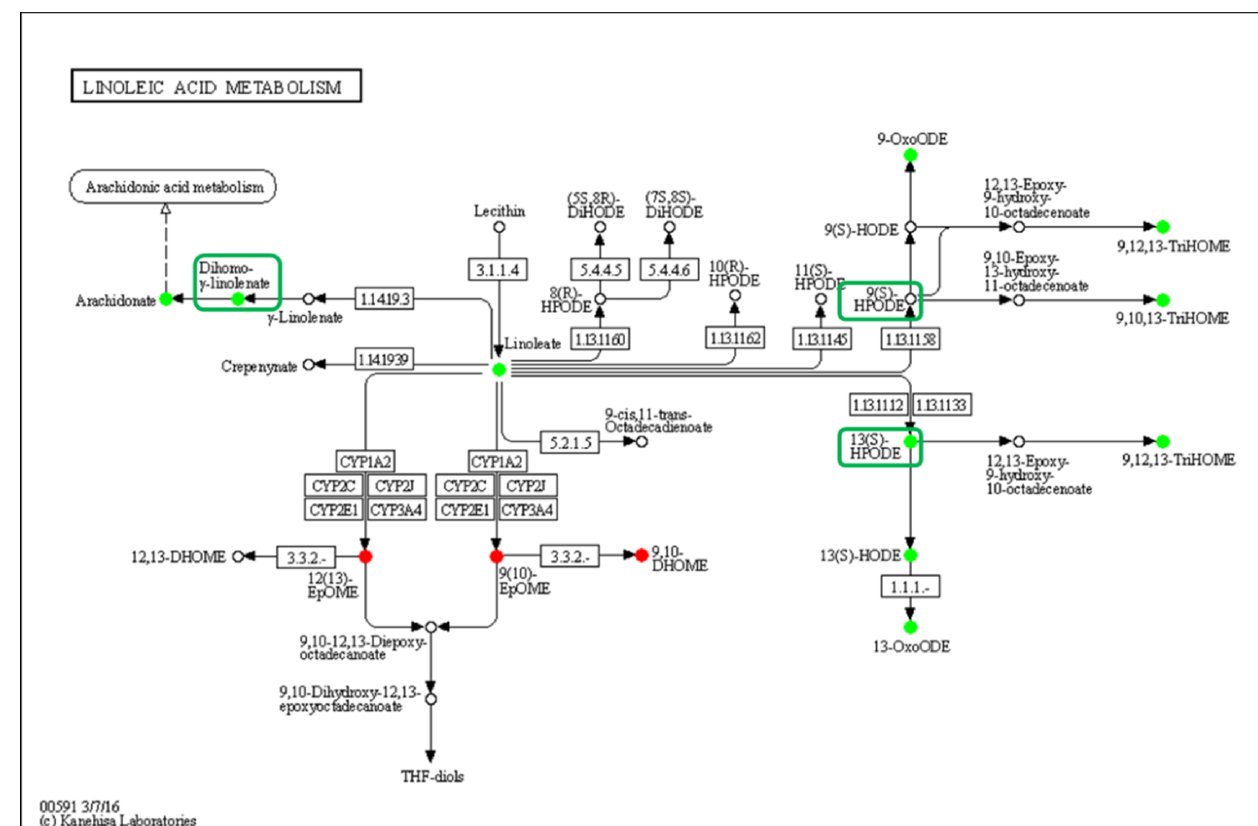
Figure 7. Enrichment of differentially oxidized lipid metabolites in the linoleic acid metabolism pathway (ko00591). No differentially expressed genes were detected, and differential metabolites are circled, while boxes highlight the elucidated signaling molecule HODEs.